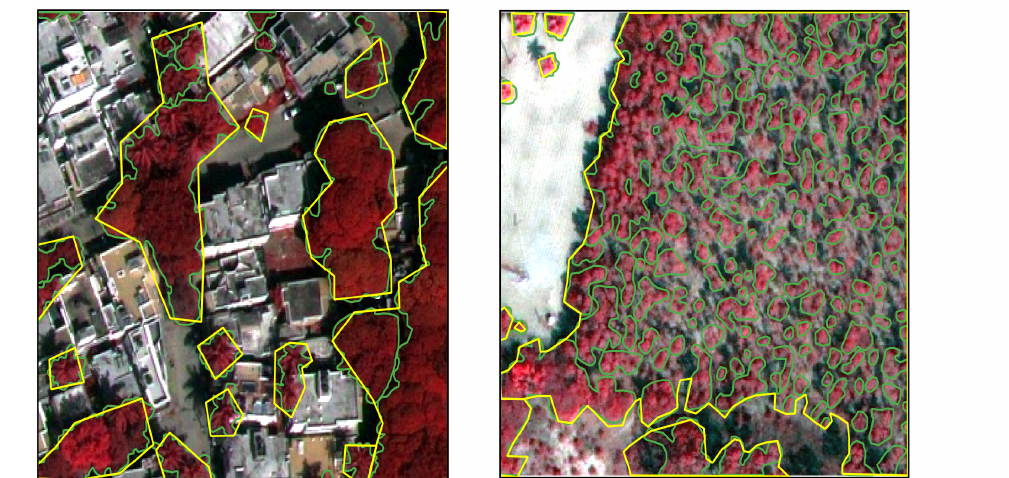
Figure 2. Illustration of the two different qualities of delineating tree crowns: an urban ( left ) and a rural ( right ) environment. Yellow denotes rough delineations and green denotes accurate delineations of tree